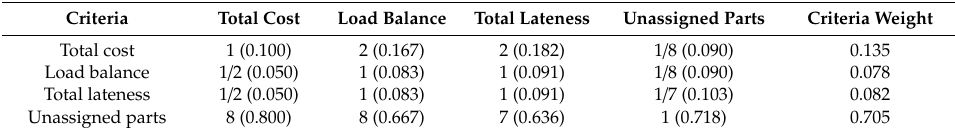
Table 2. Pairwise comparison matrix and criteria weight based on the analytic hierarchy process (AHP)